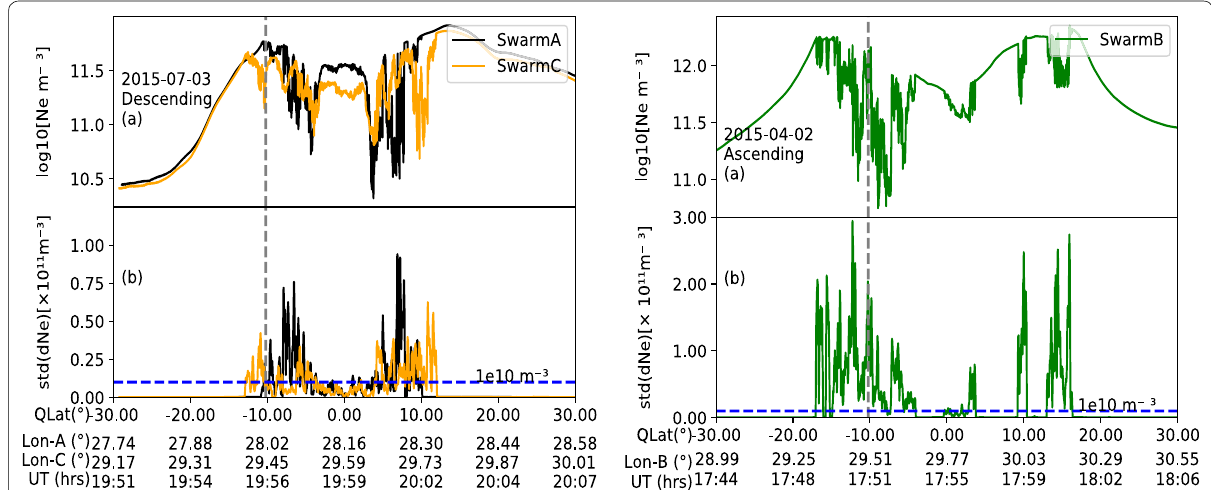
Fig. 1 Examples of N e variations for Swarm A, B, and C passes near Mbarara longitude of about 30.8 ◦ . The dashed gray vertical line represents the quasi-dipole latitude of Mbarara GPS-SCINDA ( ≈ -10.1 ◦ ). The dashed blue horizontal line in panel ( b ) represents the threshold applied for the detection of ionospheric